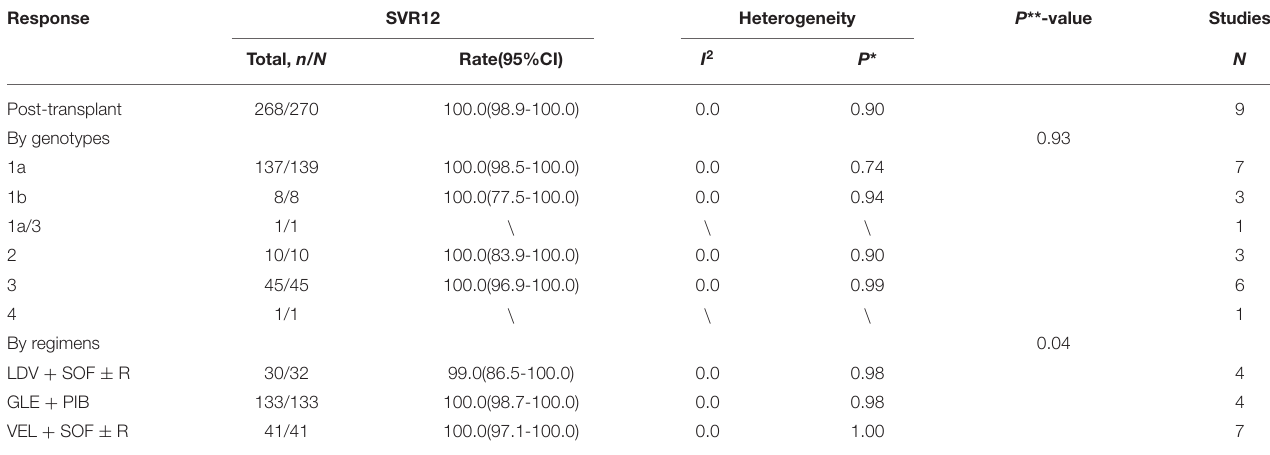
TABLE 5 | Subgroup analysis of SVR12 for